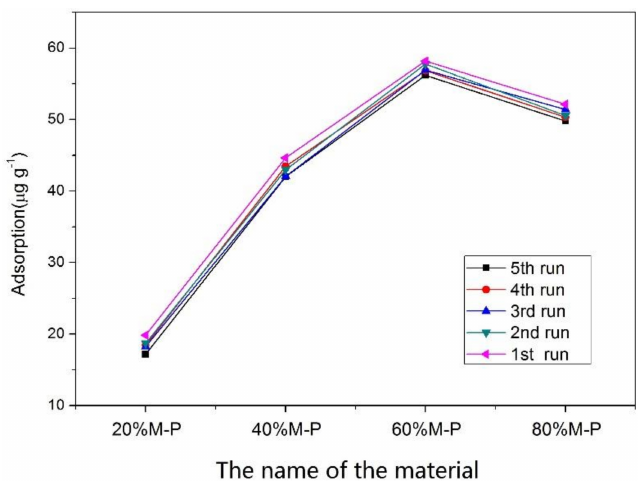
Figure 10. The influences of recycling times on the acetone adsorption by honeycomb fibers ( n = 3).